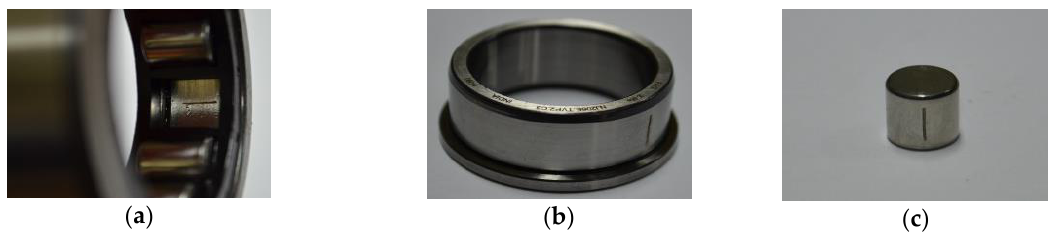
Figure 8. Illustration of the bearing, FAG NJ206-E-TVP2.